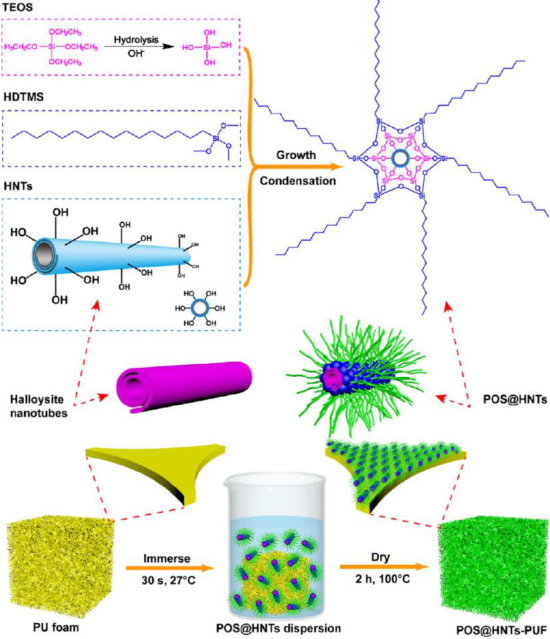
Figure 15. Schematic showing the preparation and reaction mechanism of the superhydrophobic coated polyurethane foam Reprinted with permission from F. Wu, K. Pickett, A. Panchal, M. Liu, and Y. Lvov, “Superhydrophobic Polyurethane Foam Coated with Polysiloxane-Modified Clay Nan- otubes for Efficient and Recyclable Oil Absorption”, ACS Appl. Mater. Interfaces, vol. 11, no. 28, pp. 25445–25456, July 2019, https://doi.org/10.1021/acsami.9b08023. Copyright (2019) American Chemical Society